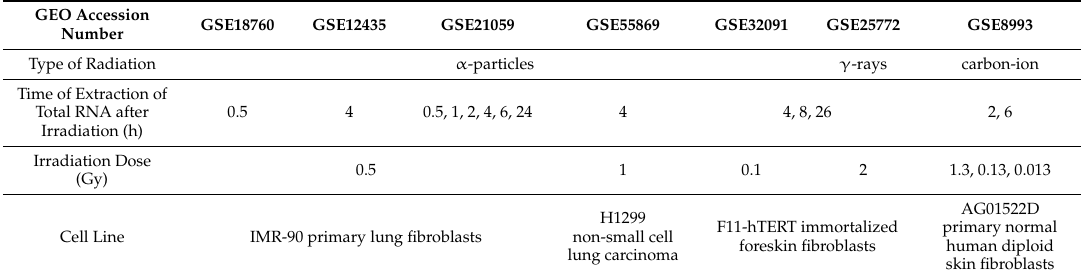
Table 10. Information about microarray datasets used in the bioinformatic